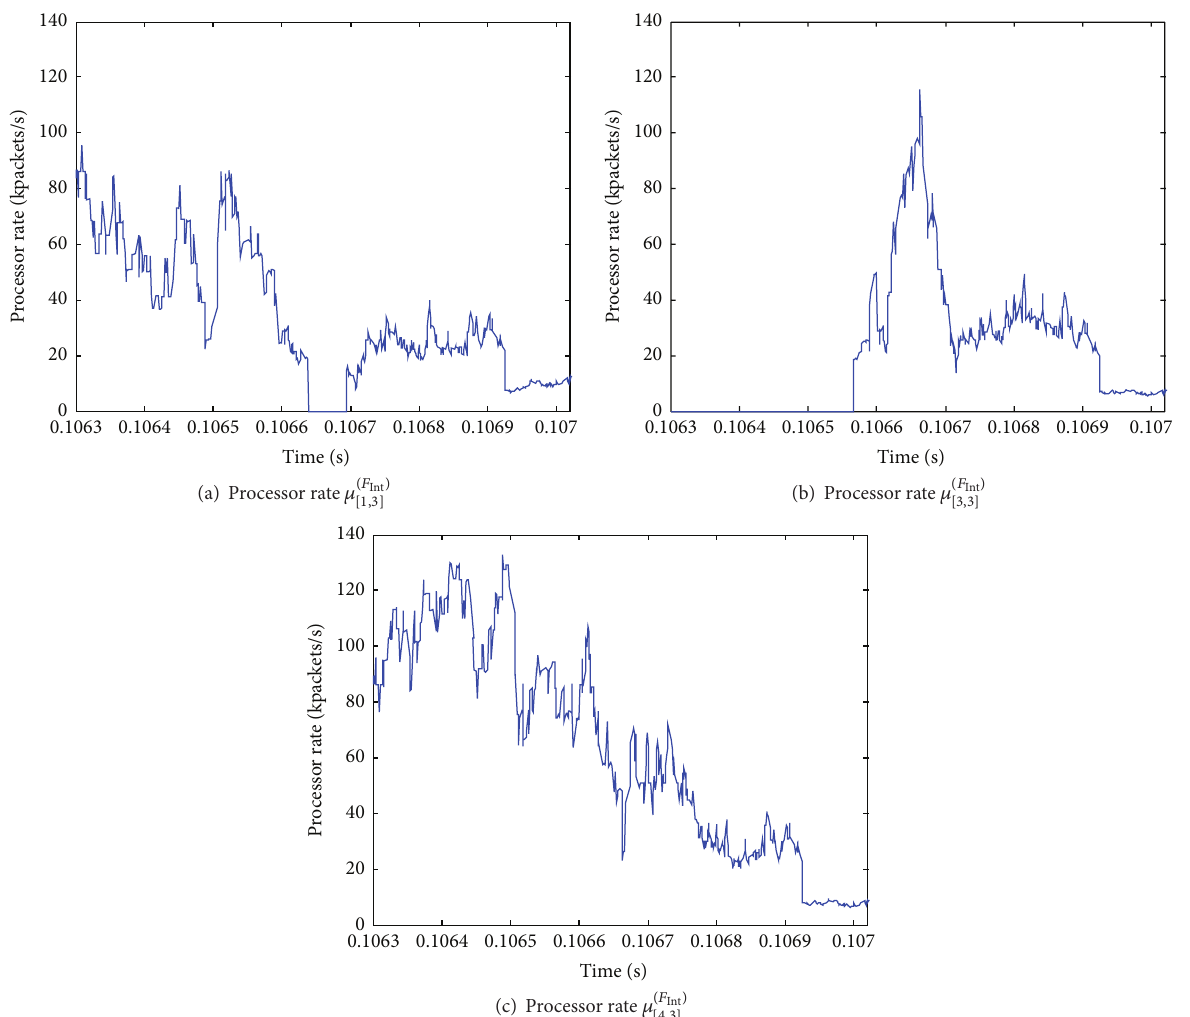
Figure 8: Processor rate assigned to the inside-function queues 𝑄 𝑚,3 , for each 𝑚 ∈ [1,𝑀]